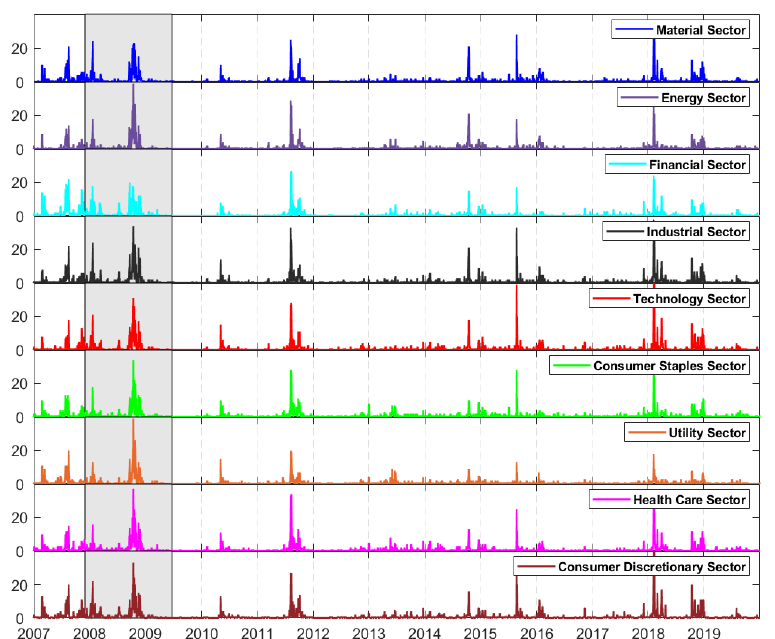
Figure 3. Number of sector-level co-jumps: see notes for Figure 1. Figure 3 shows the number of co-jumps in nine sectors in the S&P 500 market from January 2007 to December 2019. See Sections 4 and 7 for further details. Table 9. Descriptive statistics for co-jumps and idiosyncratic jumps (2007:1–2019:12)